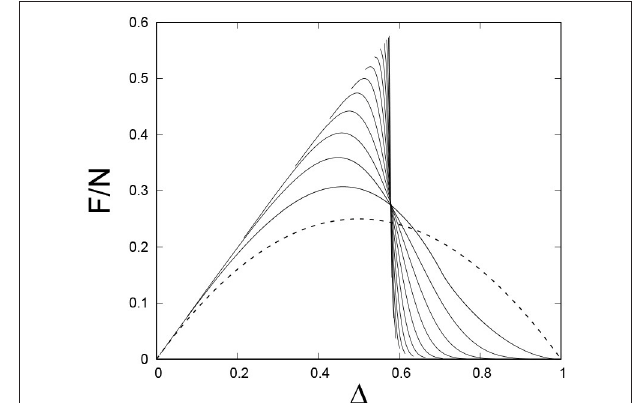
FIGURE 7 | (A) Evolution of the uniform threshold distributions on the unit interval under the real space renormalization group. (B) Rescaling the thresholds leads to a data collapse. The initial number of fibers was N Averages were taken over 10 6 samples.